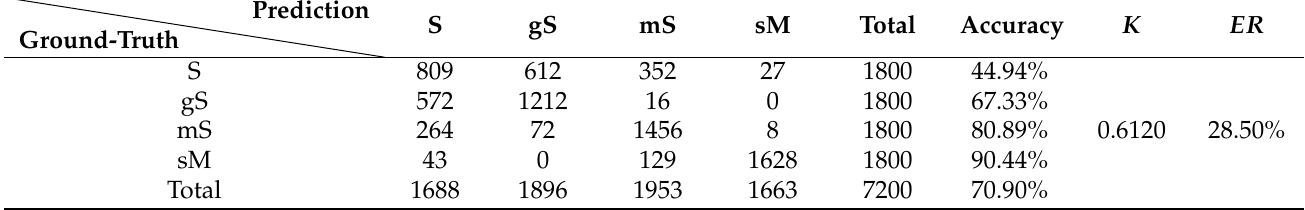
Table 2. Classification results of the Random Forest model using first-order Statistics.